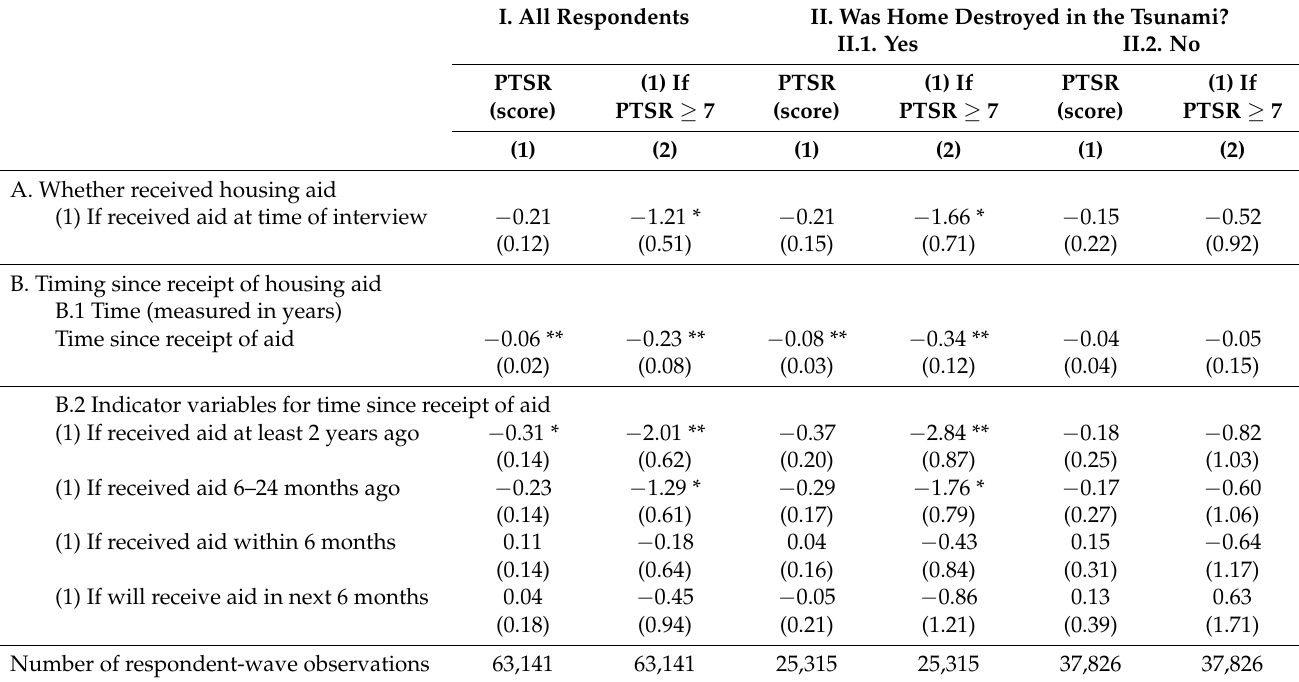
Table 6. Relationship between PTSR and housing assistance receipt as well as timing of